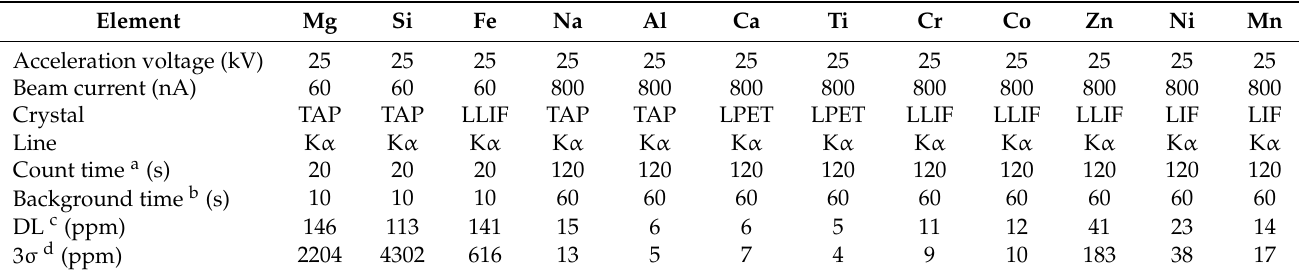
Table 1. EPMA conditions applied for MK-1 orthopyroxene